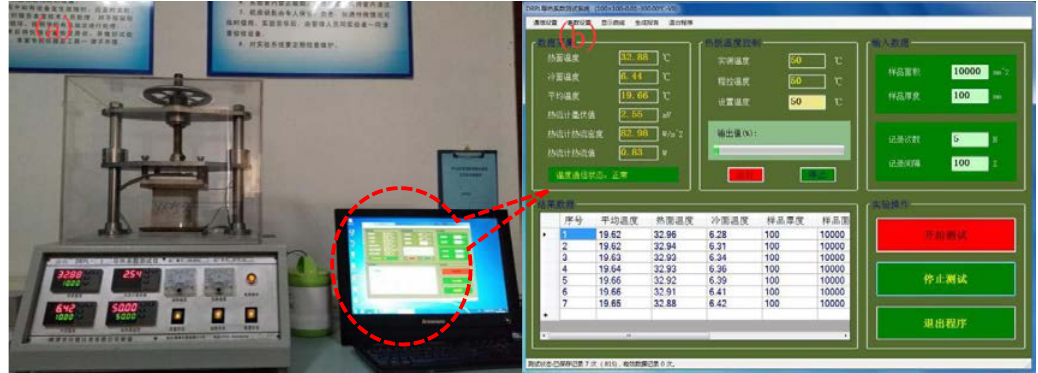
Figure 2. Measurement of thermal conductivity: ( a ) DRPL-I Thermal Conductivity Tester; ( b ) Test interface.